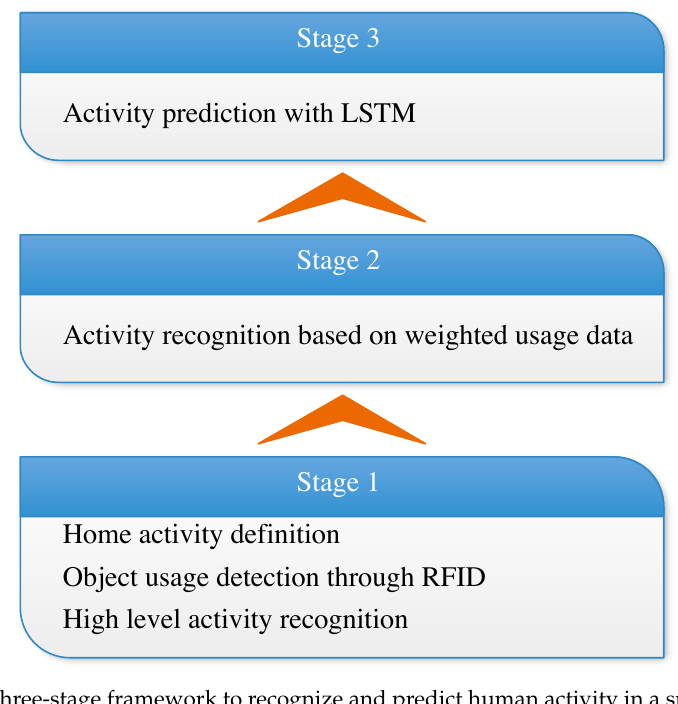
Figure 1. Three-stage framework to recognize and predict human activity in a smart